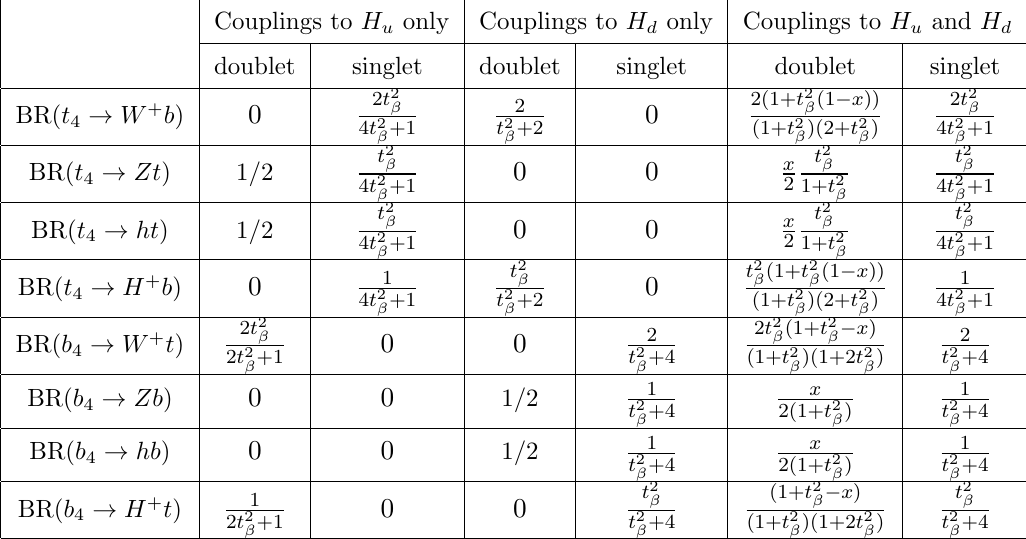
Table 5 . Branching ratios of the vectorlike quarks t 4 and b 4 into W , Z , h and H (cid:6) as a function of t (cid:12) = tan (cid:12) . These expressions are exact for heavy vectorlike masses and in the limit in which the couplings in table 2